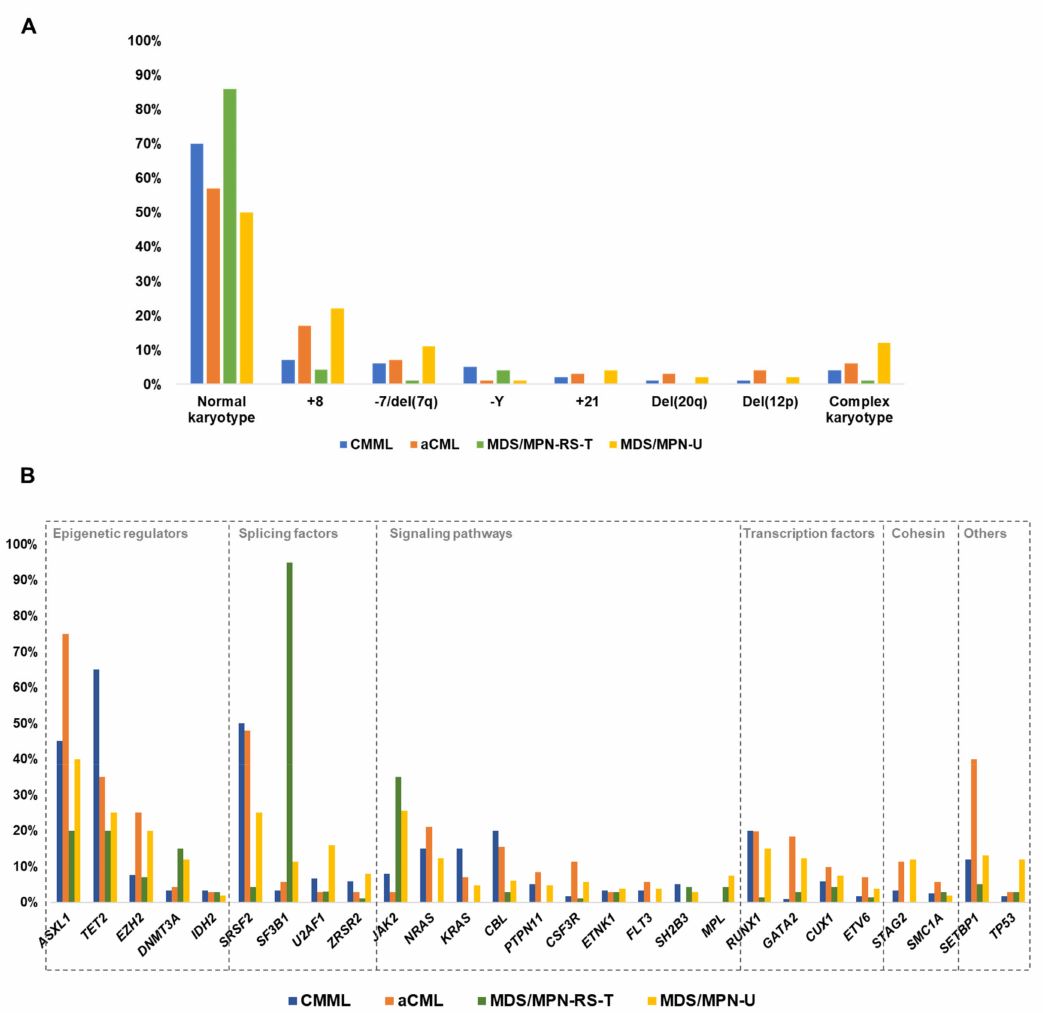
Figure 1. Genetic landscape of adult MDS/MPN. Frequency of recurrent cytogenetic alterations ( A ) and gene mutations ( B ) across the different subtypes of adult MDS/MPN. Based on data from Patnaik et al. [3], Palomo et al. [4], Breccia et al. [13], Jeromin et al. [15], DiNardo et al. [20], Such et al. [23], Tang et al. [24], Wassie et al. [25], Patnaik et al. [26] and